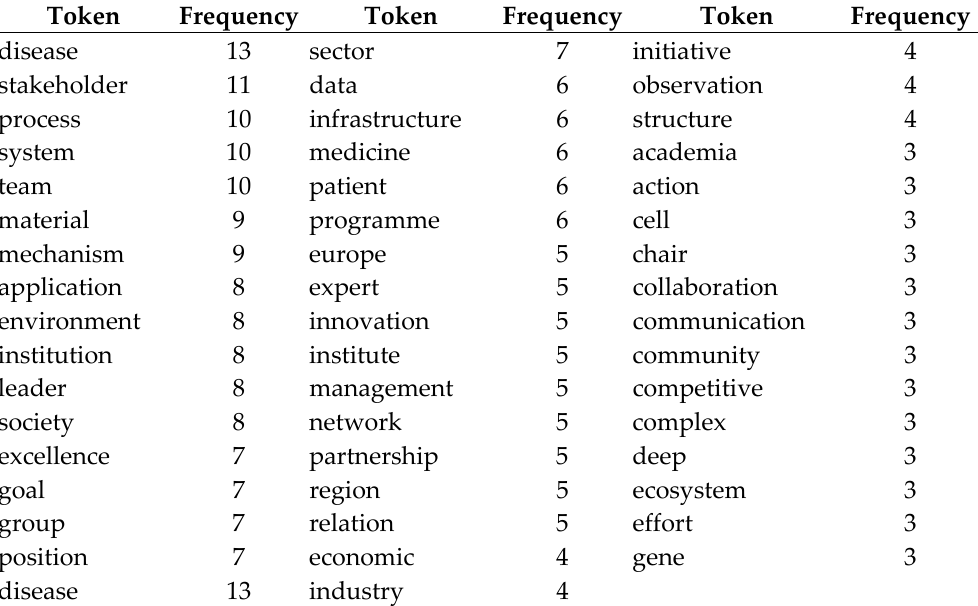
Table 2. Top 50 of most frequent tokens in project